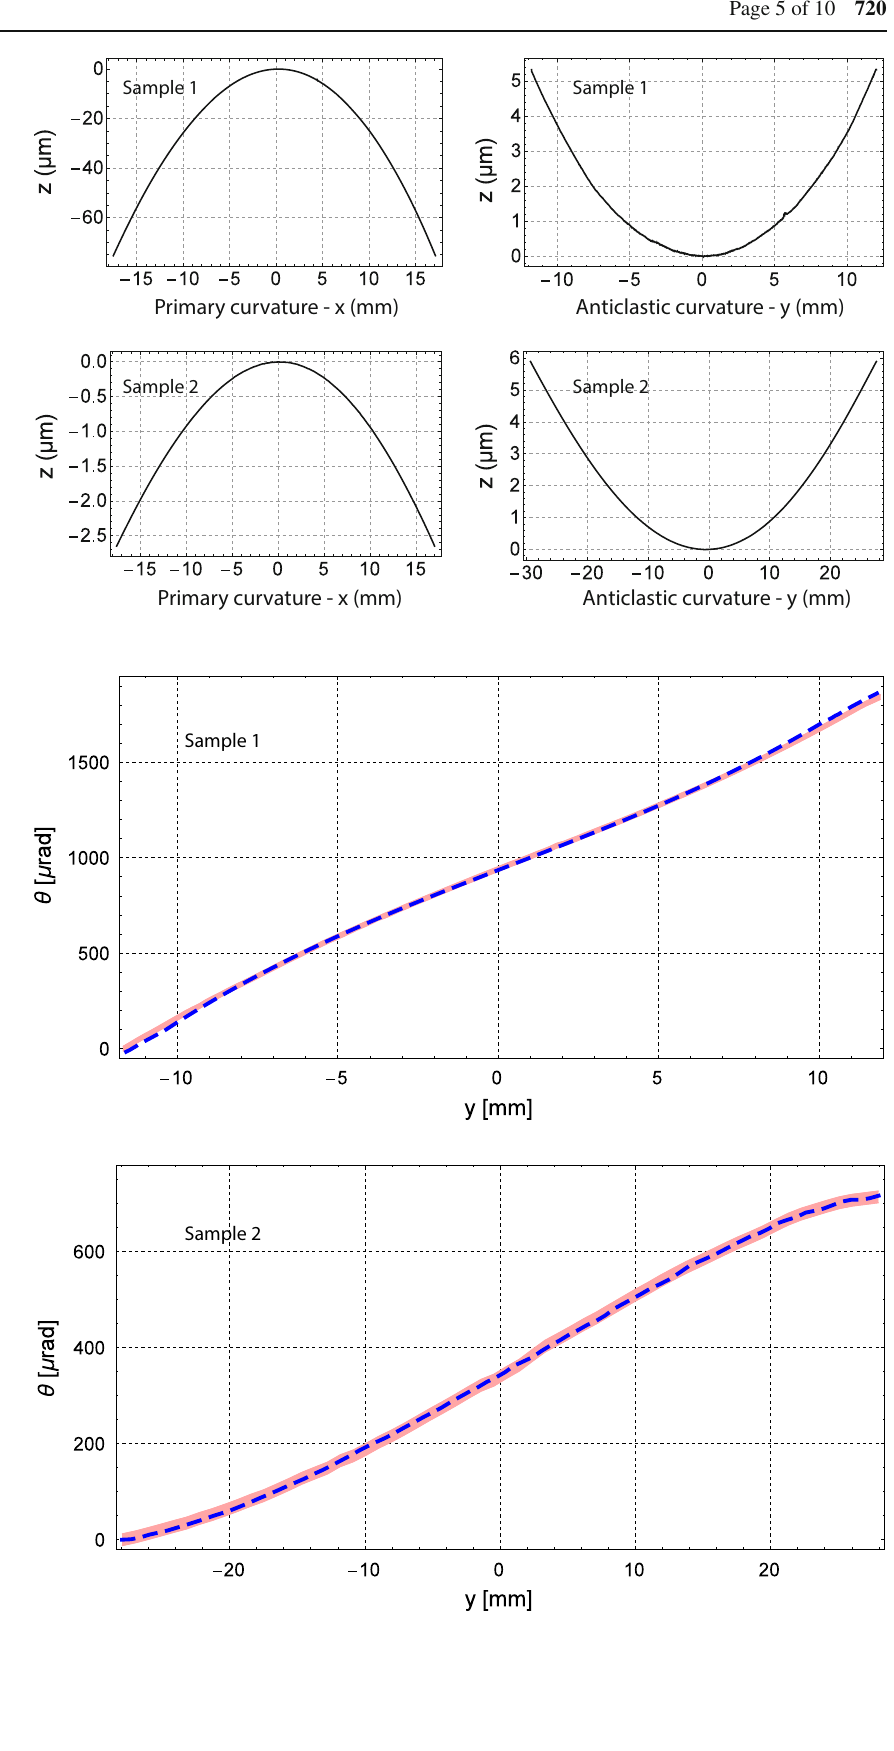
Fig. 3 Interferometric measurement of the plate crystals. Left column: deformation along the direction perpendicular to particle beam propagation, i.e. the primary curvature – z vs x position. Right column: deformation along the direction of particle beam propagation, i.e. the anticlastic curvature – z vs y position